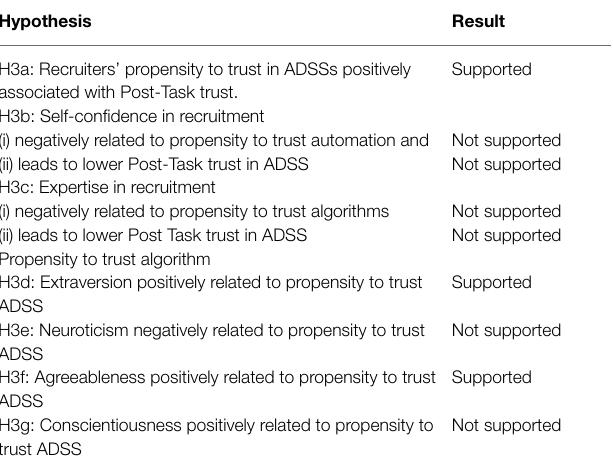
TABLE 4 | Hypothesis H3 test